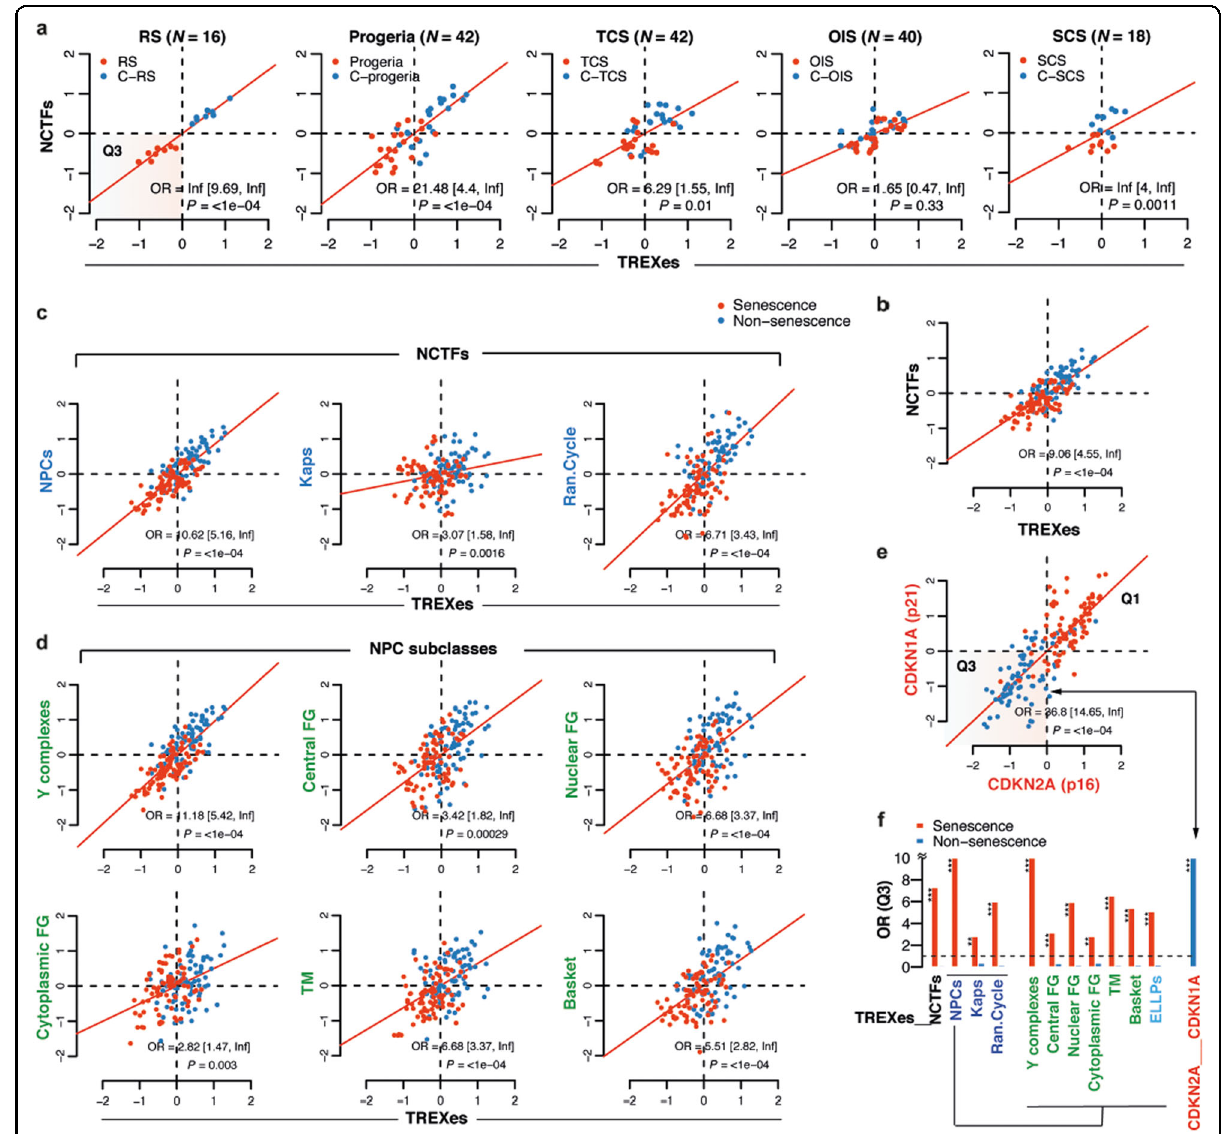
Fig. 1 TREXes and NCTFs show distinctive enrichment patterns in various types of senescent cells. a Analysis of the two-dimensional differential mean expression of TREXes and NCTFs in fi ve senescent cell types (red dots) of different origins and their young counterparts (blue dots). After gene set mean expressions were z-standardized, the odds ratio (OR) and statistical signi fi cance were calculated by Fisher 2-tailed exact test. Horizontal and vertical dashed lines are median points for TREXes and NCTFs. Senescent cells were more likely to be in the lower left-hand quadrant (Q3), and the odds ratios are shown with 95% con fi dence intervals and p -values. b – d Panel b through d are compilations of the data on fi ve senescence types showing the enrichment patterns of TREXes and NCTFs. b TREXes and NCTFs in all fi ve types of senescent cells. c TREXes and subclasses of NCTFs: NPCs, Kaps, and Ran cycle. d TREXes and six distinct subclasses of NPC: Y complexes, central FG, nuclear FG, cytoplasmic FG, TM, and basket. e Two-dimensional differential mean expression of CDKN2A (p16) and CDKN1A (p21), well-known senescence markers, in all senescent cell types. f Bar plot representing the odds ratios (Q3) of the NCTFs, their subclasses, and TREXes as shown in ( b ) through ( e ). The red bar indicates the odds ratio (Q3) of the senescent cells, and the blue bar indicates the odds ratio of the nonsenescent cells. The color legends on the x -axis, i.e., black, blue, green, and red, represent ( b – e ), respectively. RS replicative senescence, TCS tumor cell senescence, OIS oncogene-induced senescence, SCS stem cell senescence, Kaps karyopherins, FG phenylalanine – glycine repeat, TM